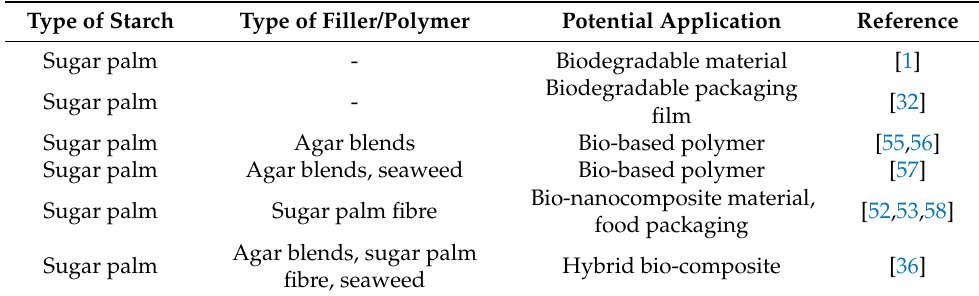
Figure 6. Tensile stress-strain of plasticized sugar palm starch (SPS) [1]. Table 4. Thermoplastic sugar palm starch